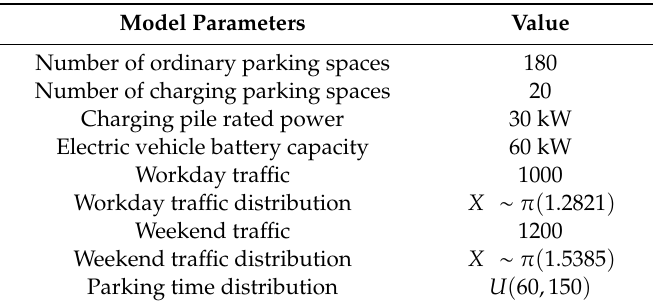
Table 1. Main model parameters.